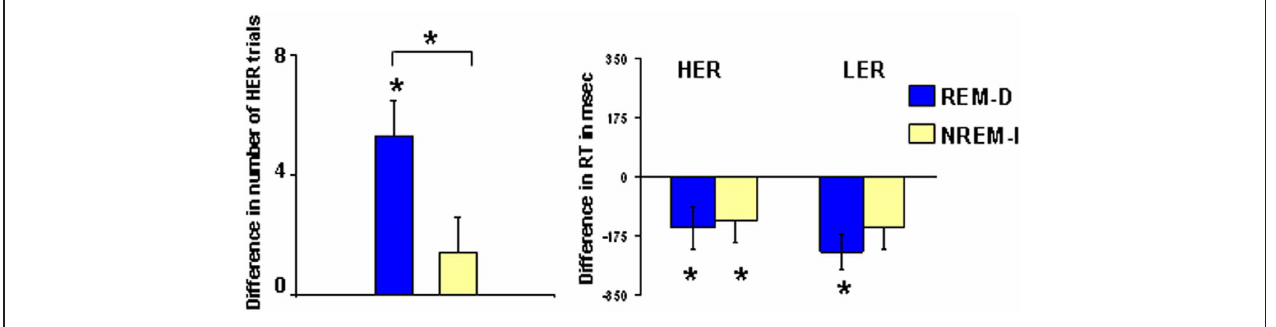
FIGURE 3 | Difference in the number of high emotional reactivity trials (HER, see Methods for details) and in reaction times for HER and low emotional reactivity trials (LER) after REM sleep deprivation (REM-D) or